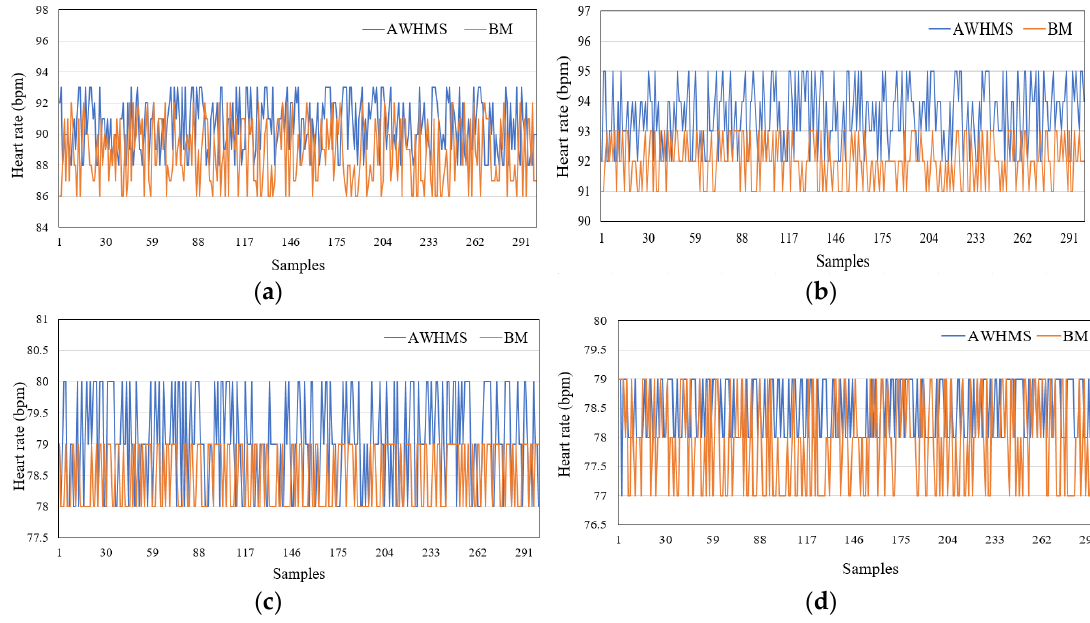
( d ) Figure 8. Experimental tests for ( a ) standing up rapidly from a seated position, ( b ) lying on the ground, ( c ) rapidly sitting down on a chair, and ( d ) lying on the side. 5. Parameter Measurements This section will present the measurement results for the HB and ACC sensors. 5.1. HR Measurements The experiment described in Section 4.1 was conducted to evaluate the HR measurement accuracy of the proposed AWHMS. Figure 9 illustrates the 300 average samples that were recorded for each group from the HB sensor experiment for both the AWHMS and the BM device to facilitate comparison and statistical analysis. Figure 9a–d show the HR measurement during physical activities (jogging for groups one and two and walking for groups three and four). Statistical analysis was performed for the two datasets to validate the proposed AWHMS as described in Section 6.1. HB